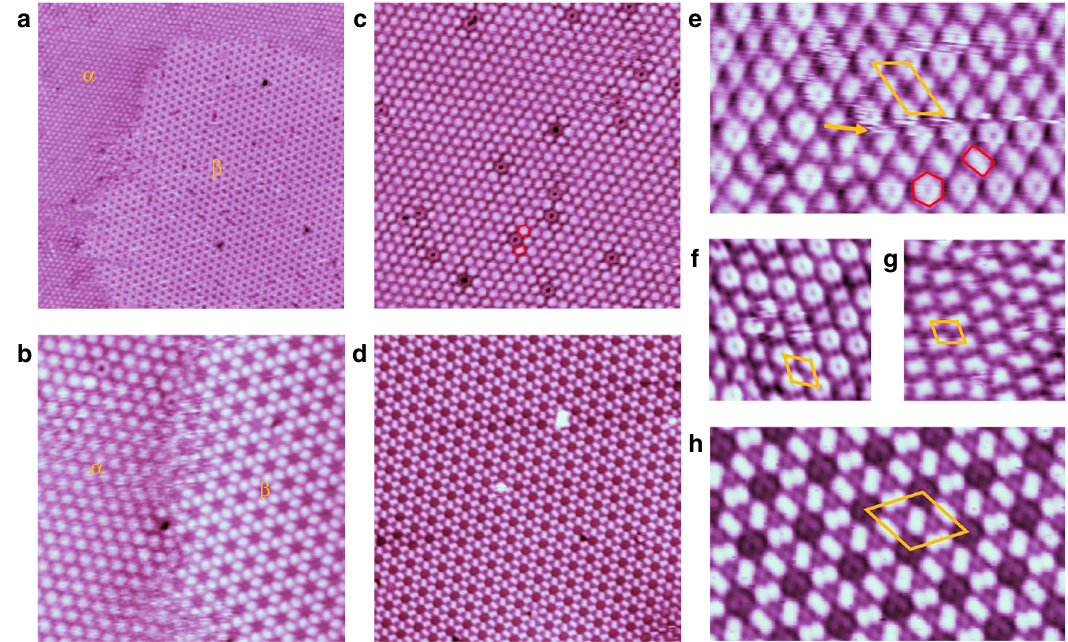
Fig. 1 STM images of α and β phases of 2D CO coexisting on Cu(111) at 77 K. a STM image of a large area with coexisted α and β phases on Cu(111). b STM image of coexisted α and β phases with obscure domain boundary, indicating that the α and β phases are translated into each other during scanning. c , d STM images of single domain with pure α and β phases, respectively. e – g High-resolution STM images of α phase in different areas. The rhomboids represent the unit cells, which correspond to 4 × 7, 4 × 4, and 4 × 3 superlattices with respect to Cu(111), respectively. The two types of protrusions with different shapes are marked by red parallelograms and hexagons in c and e . h High-resolution STM image of β phase. The rhombus represent the unit cell of β phase with a period of 1.33 nm, corresponding to (3 √ 3 × 3 √ 3) R30 ˚ with respect to Cu(111). The sizes of the images are: a 50.0 × 50.0 nm; b 17.0 × 17.0 nm; c 19.4 × 19.4 nm; d 23.0 × 23.0 nm; e 10.8 × 6.4 nm; f 5.5 × 5.5 nm; g 5.0 × 5.0 nm; h 7.6 × 4.6 nm. The scanning parameters are: a V tip = − 2.0 V, I = 31 pA. b V = 0.48 V, I = 196 pA. c V = 0.50 V, I = 195 pA. d V = − 1.00 V, I = 90 pA. e – g V = − 1.00 V, I = 200 pA. h V = − 1.00 V, I = 300 tip tip tip tip tip